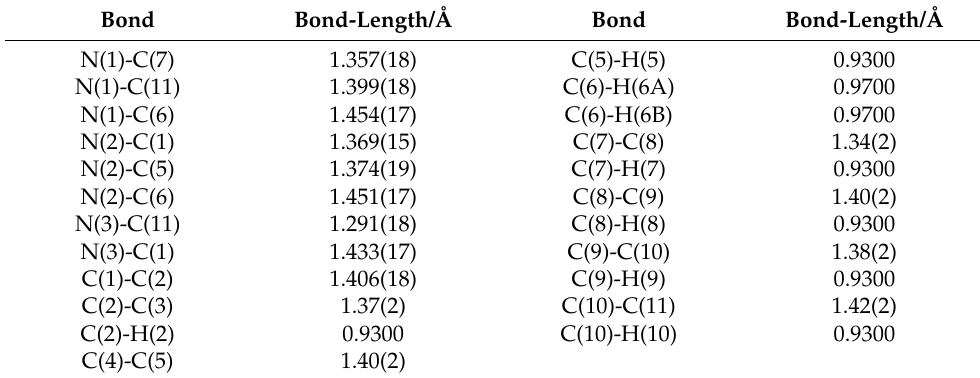
Table 2. The bond length of Azacyanine 1.